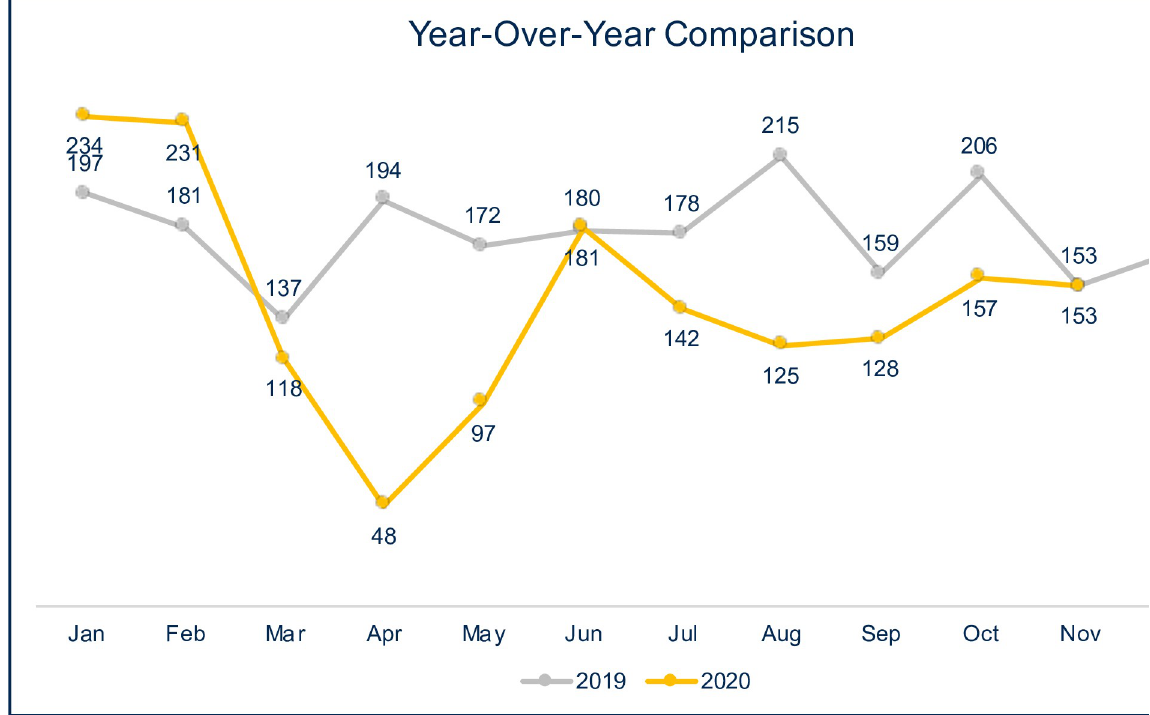
Fig 2. Referrals for PT per month in 2019 versus 2020. The numbers of PT referrals per month for the year 2019 are linked by the gray line. The numbers of PT referrals per month in 2020 are linked with the yellow line. Two major drops in referrals were seen in 2020.